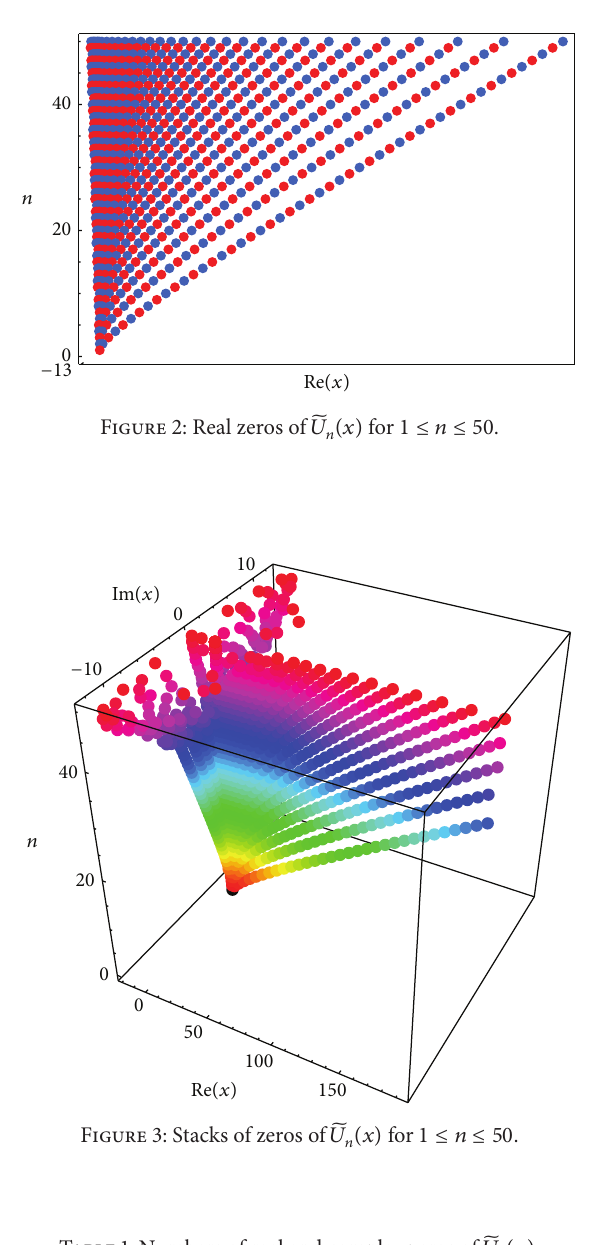
Table 1: Numbers of real and complex zeros of Degree 𝑛 Real zeros Complex zeros